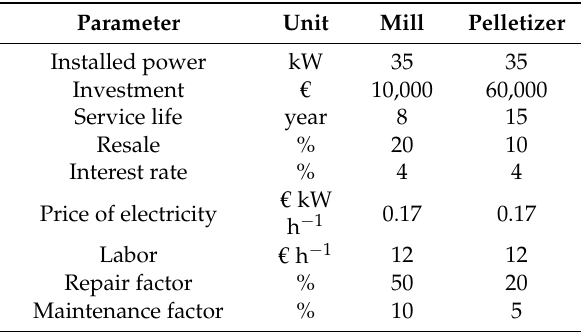
Table 5. Pelleting cost